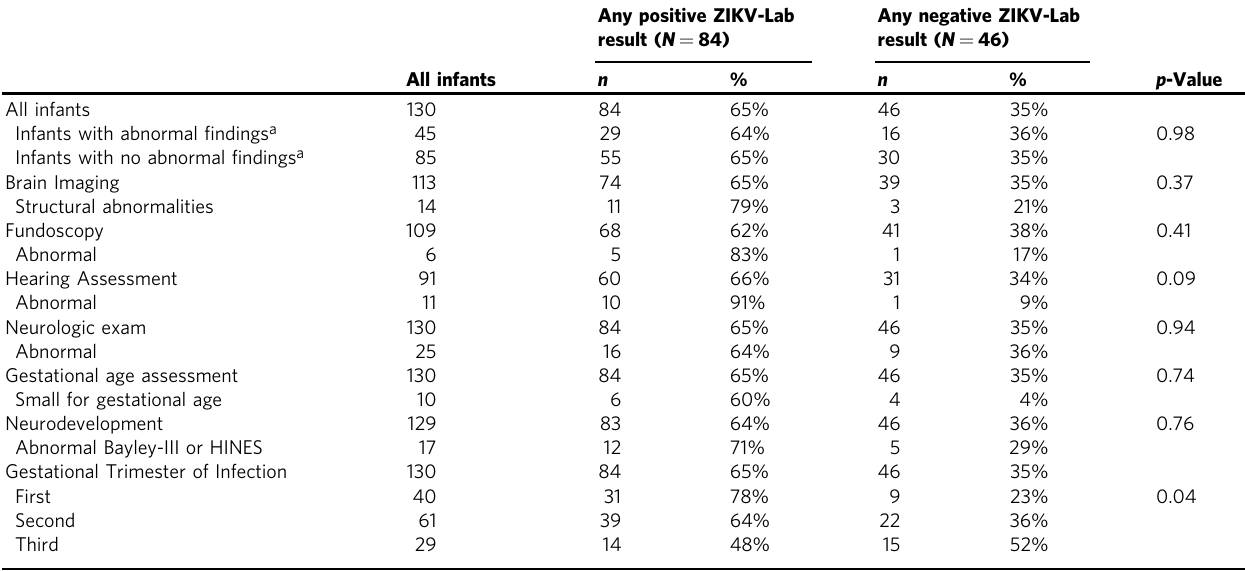
Table 4 Association between ZIKV laboratory results, clinical fi ndings, and gestational age at infection.